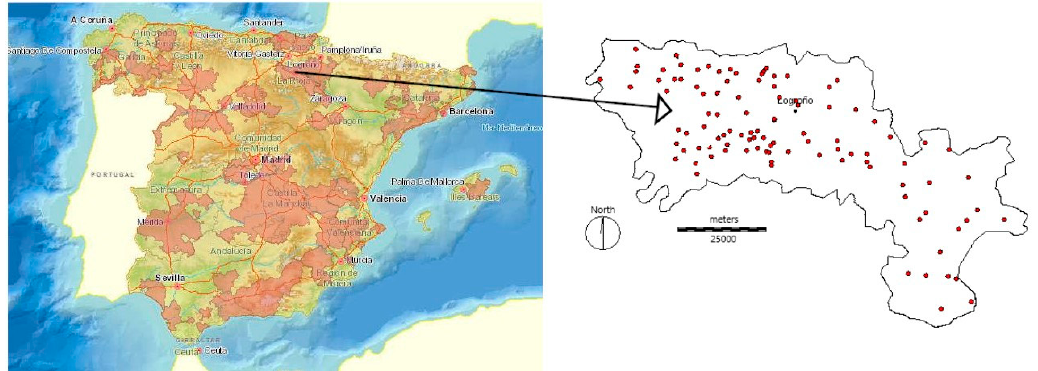
Figure 1. Location map of La Rioja Vineyards in Spanish Vineyards (extracted from https://sig.mapama.gob.es/geoportal/) and location of sample points.